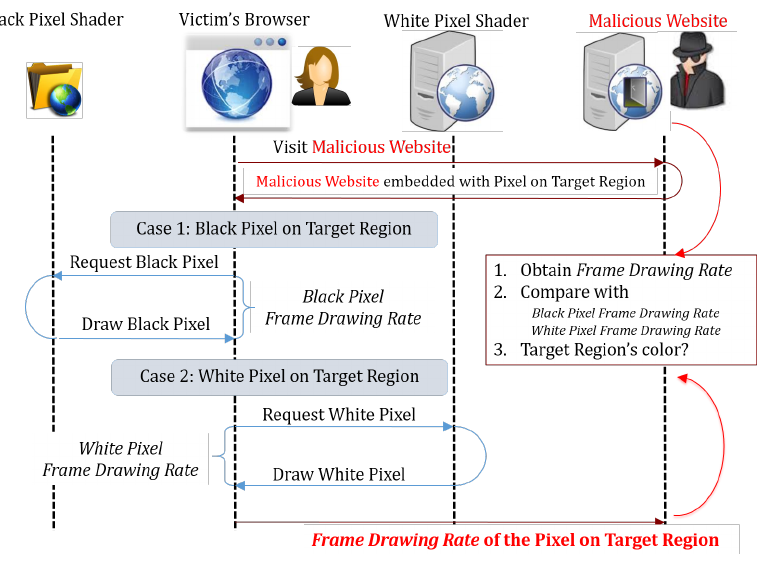
Figure 8. Pixel-based timing probing